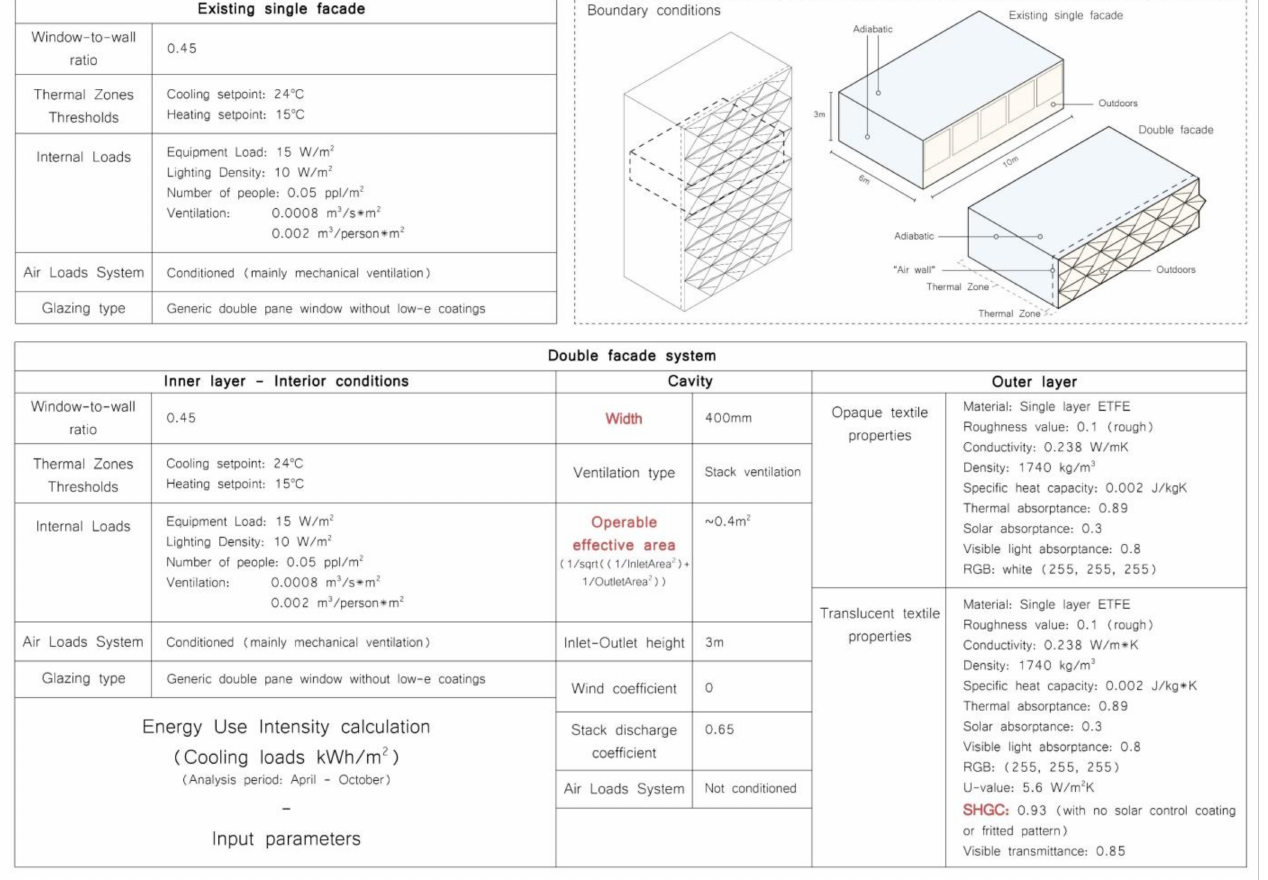
Figure 12. Overview of the input parameters and boundary conditions for the energy use intensity